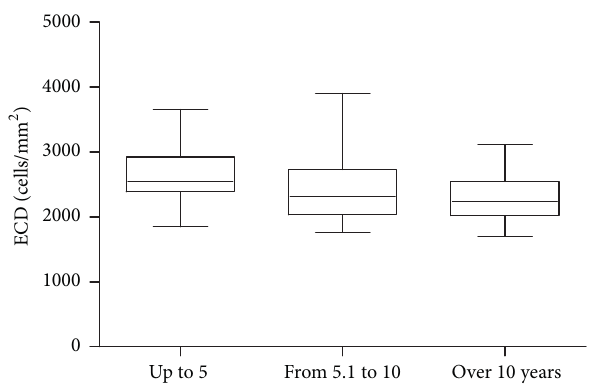
Figure 3: ECD values in relation to the duration of